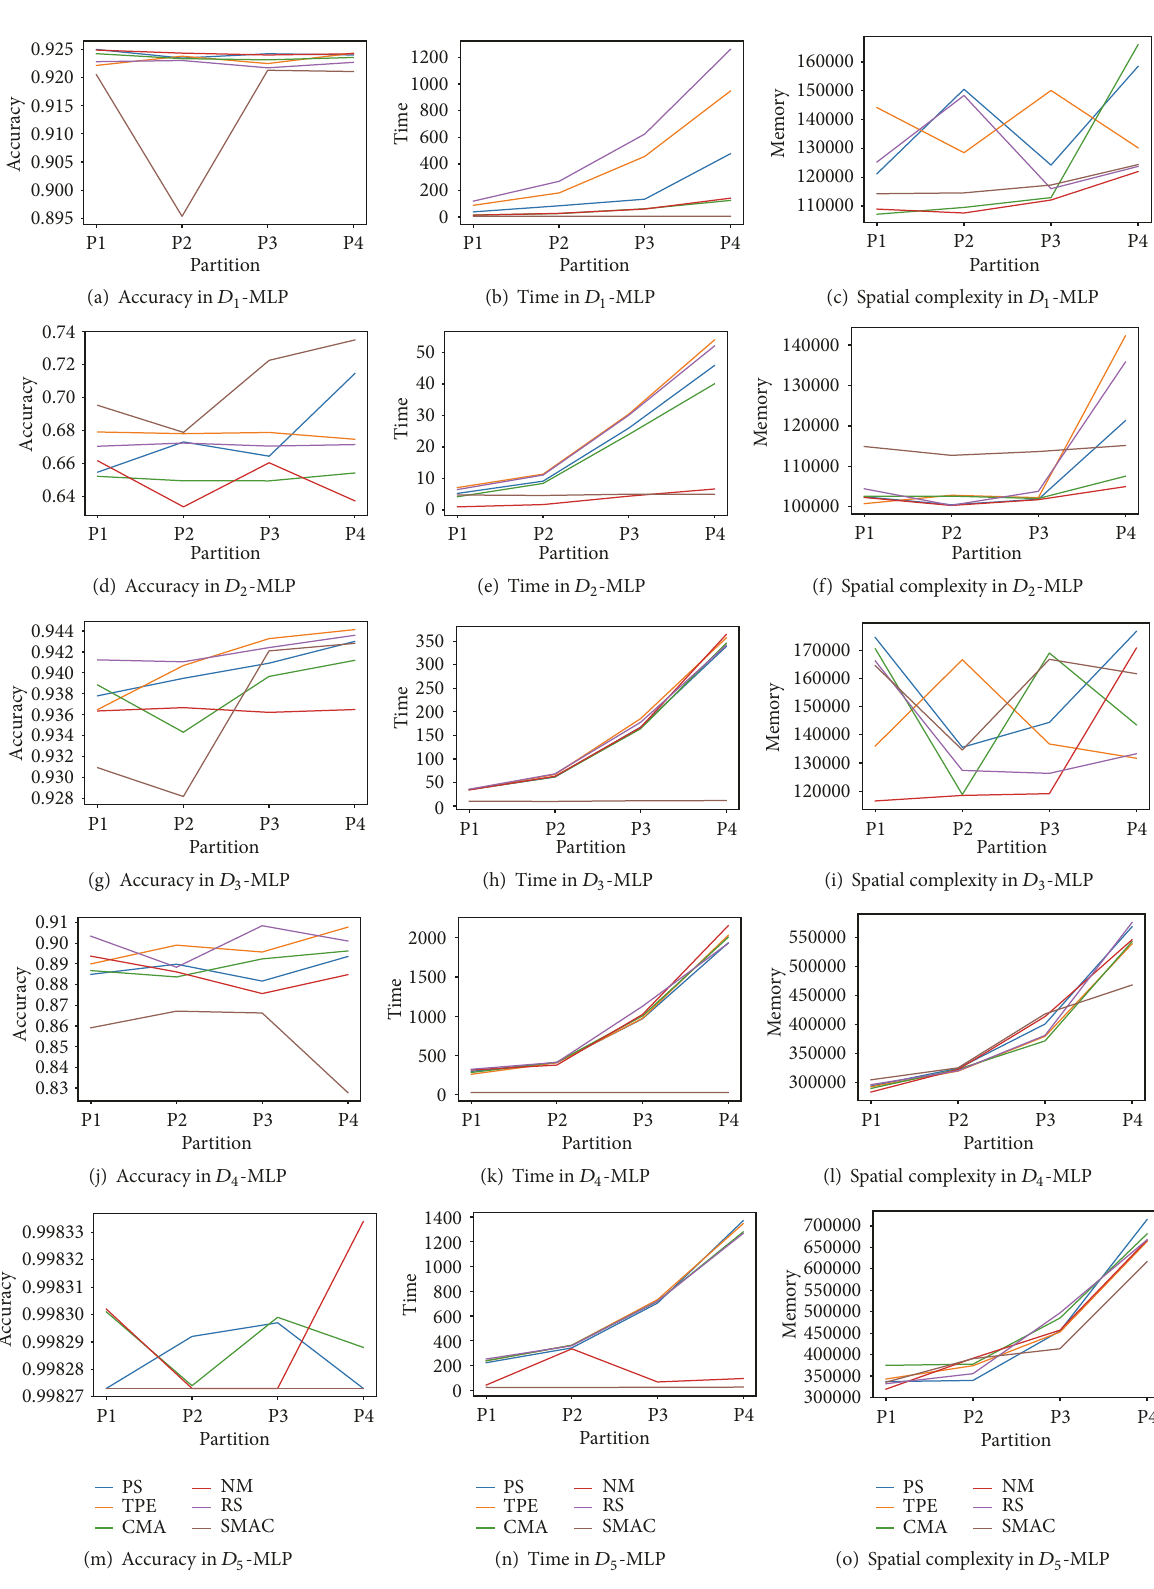
Figure 3: Accuracy, time, and spatial complexity of